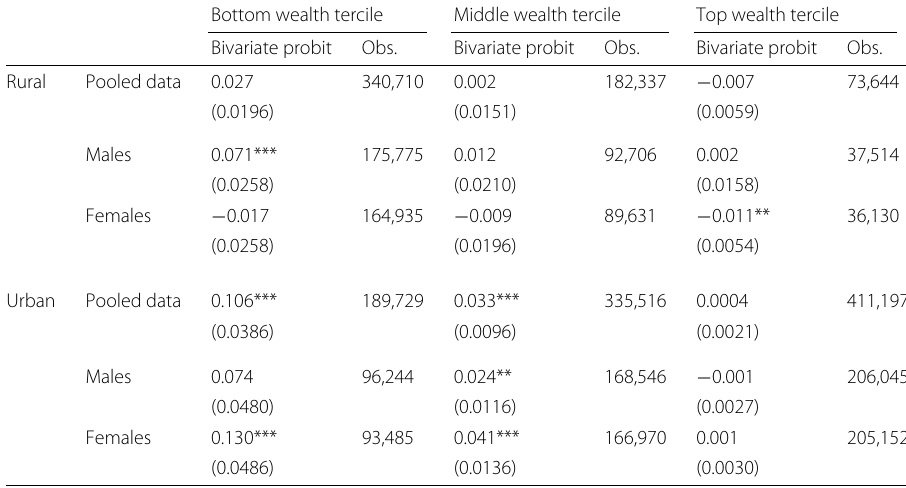
Table 4 Rural-urban effects of remittances on secondary school enrollment Bottom wealth tercile Middle wealth tercile Top wealth tercile Bivariate probit Obs. Bivariate probit Obs. Bivariate probit Obs. Rural Pooled data 0.027 340,710 0.002 182,337 − 0.007 (0.0196) (0.0151)